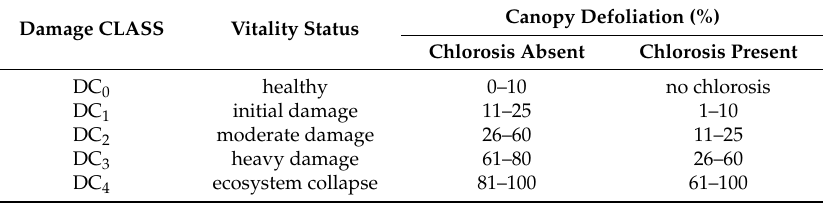
Table 2. Forest health status classification scheme developed during the sampling campaign in 1998. Adopted from [17,38]. The same scheme was used during the campaign in